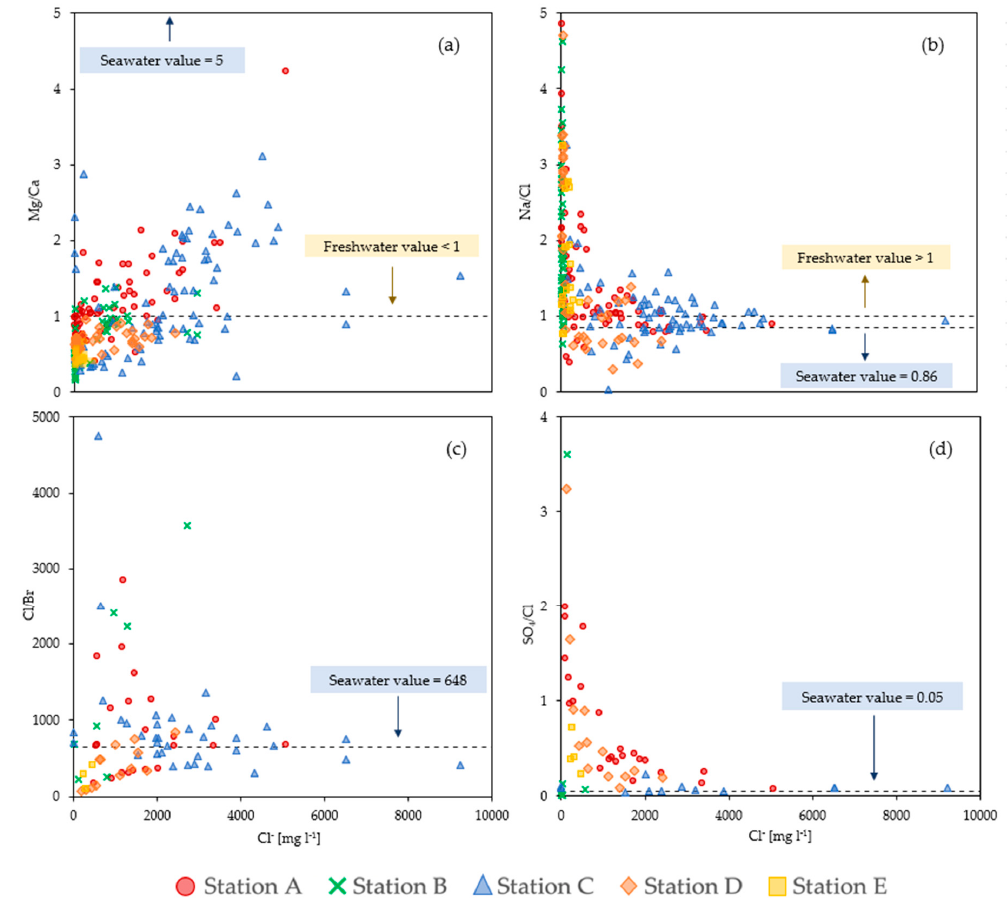
Figure 8. Mg/Ca ( a ), Na/Cl ( b ), Cl/Br ( c ), and SO 4 /Cl ( d ) molar ratios as function of Cl − concentration Figure 8. Mg / Ca ( a ), Na / Cl ( b ), Cl / Br ( c ), and SO 4 / Cl ( d ) molar ratios as function of Cl − concentration [mg L − 1 [mg L − 1 ].